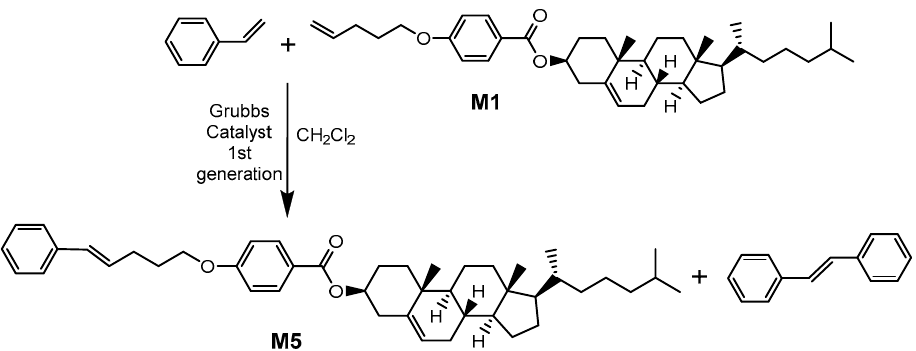
Figure 1. View of independent molecules in the unit cell of M2 ( A ) and M3 ( B ). Intermolecular contacts are shown as dotted blue lines. Color codes: H white; C gray; O red; B orange.